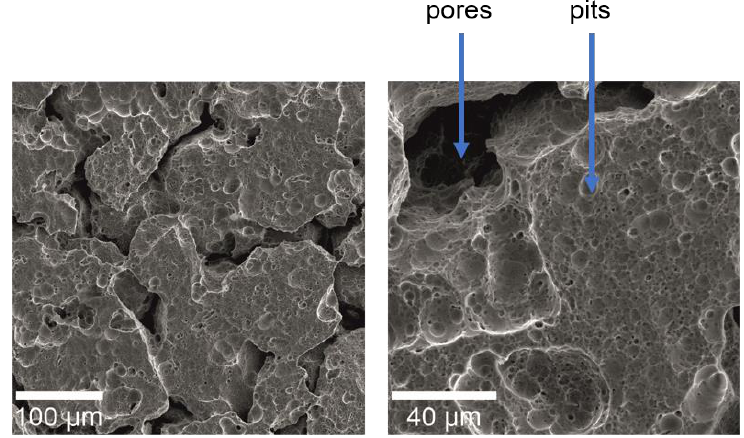
Figure 2. SEM micrographs of Ti23Zr25Nb alloy electrochemically etched in 1 M H 3 PO 4 + 2% HF in the voltage of 10 V vs. OCP for 60 min (B1*) with different magnifications.